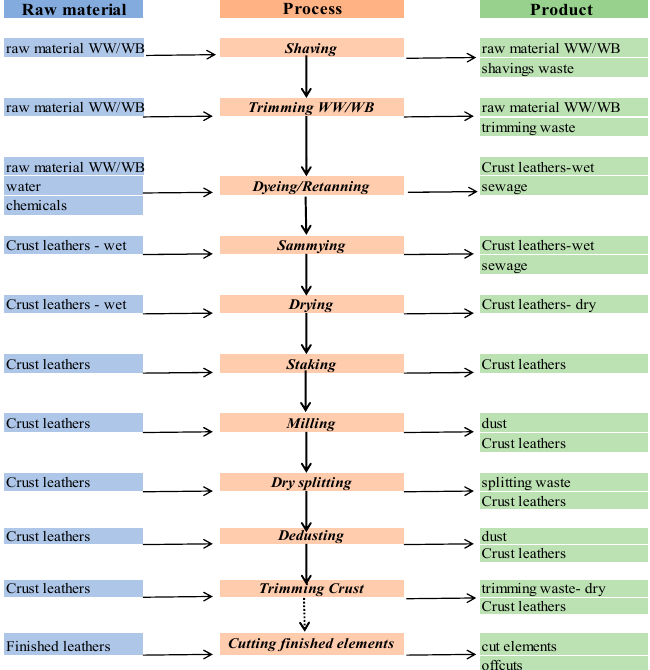
Figure 1. An exemplary technological diagram of leather processing. At the very beginning, the raw material in the form of WW (hides from the tanning plant) or WB (hides after chrome tanning) is subjected to shaving. This operation aims to reduce the thickness of the hides by shaving them off with special knives from the flesh side to the required thickness. At this stage, waste is produced in the form of shavings waste, or small pieces of hides. The amount of waste can reach up to 150 Mg per month. After being shaved in this way, hides proceed to the trimming process as wet hides. After the trimming operation, many hides have damaged edges and leather scraps appear which can disrupt the work at later stages. Hence they need to be trimmed and the edge lines of the hides need to be evened out. Trimming waste is already present in the form of larger pieces of hide and the amount varies between 3–4 Mg/month. The moisture content of trimming waste as well as shavings varies between 50–60%. The hides prepared in this way go to the dyeing drum, where dyeing, retanning and fatting of the hides take